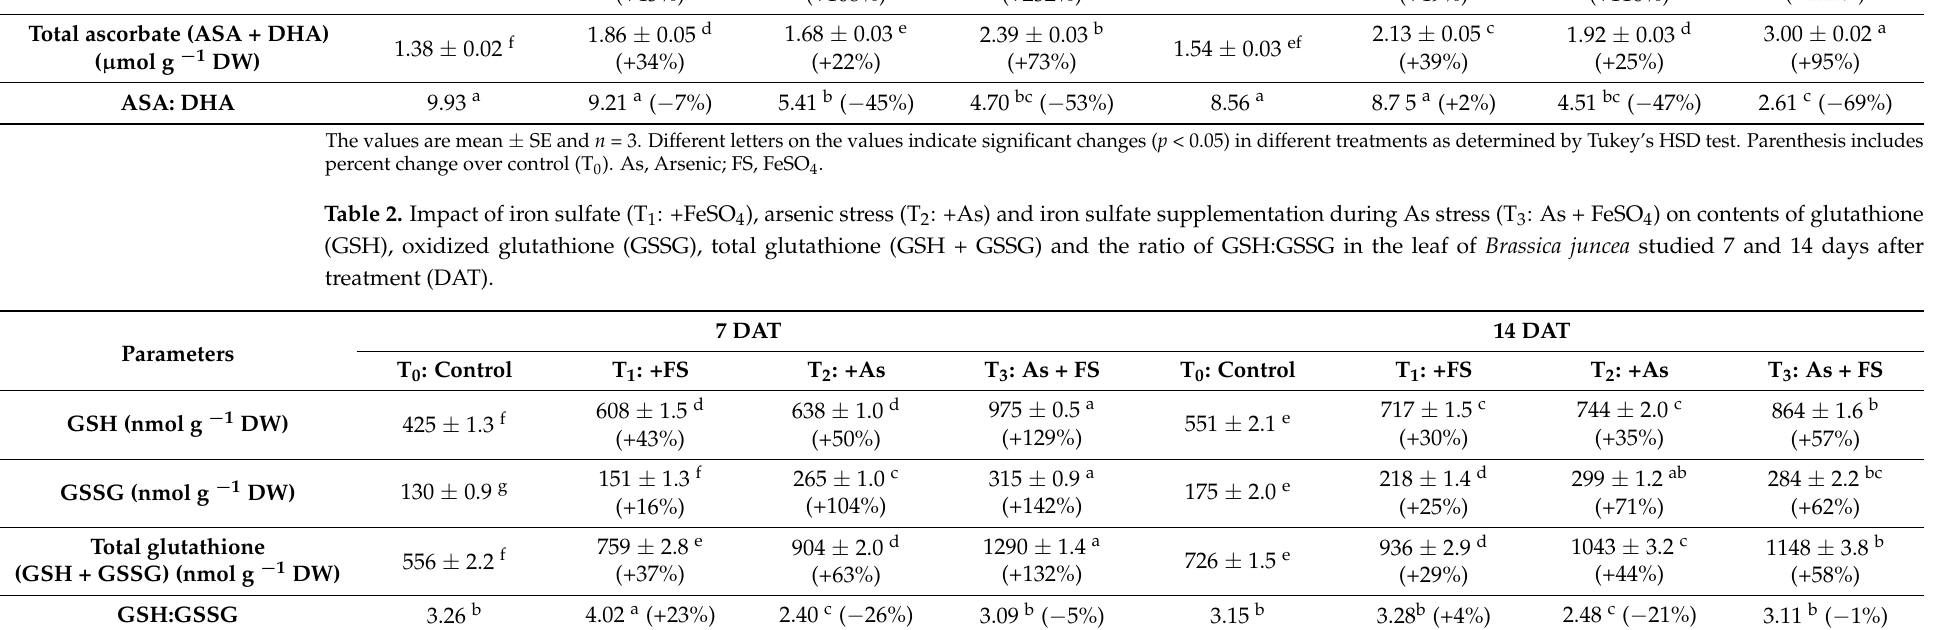
Total ascorbate (ASA + DHA)